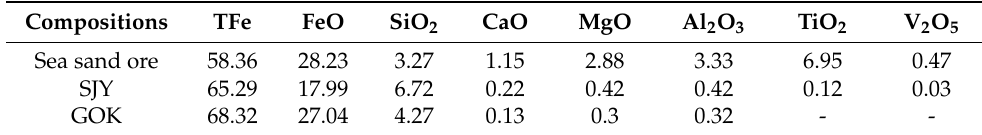
Table 1. Chemical composition of experimental raw materials